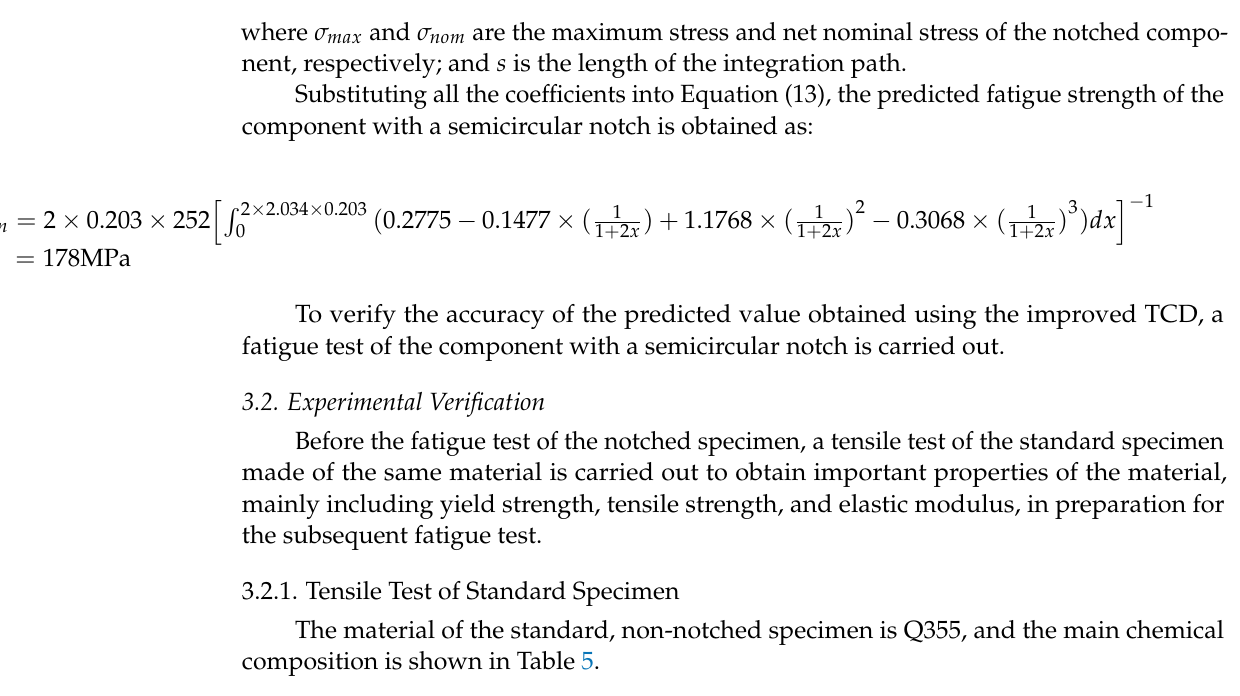
Table 5. Basic chemical composition of